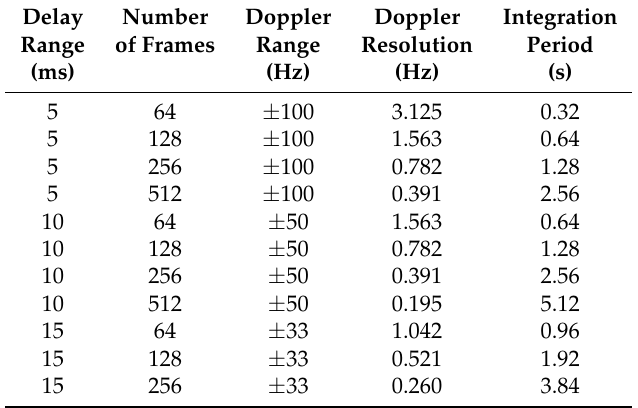
Table 1. Characteristics of different DAMSON sounder waveforms (3 kHz bandwidth)